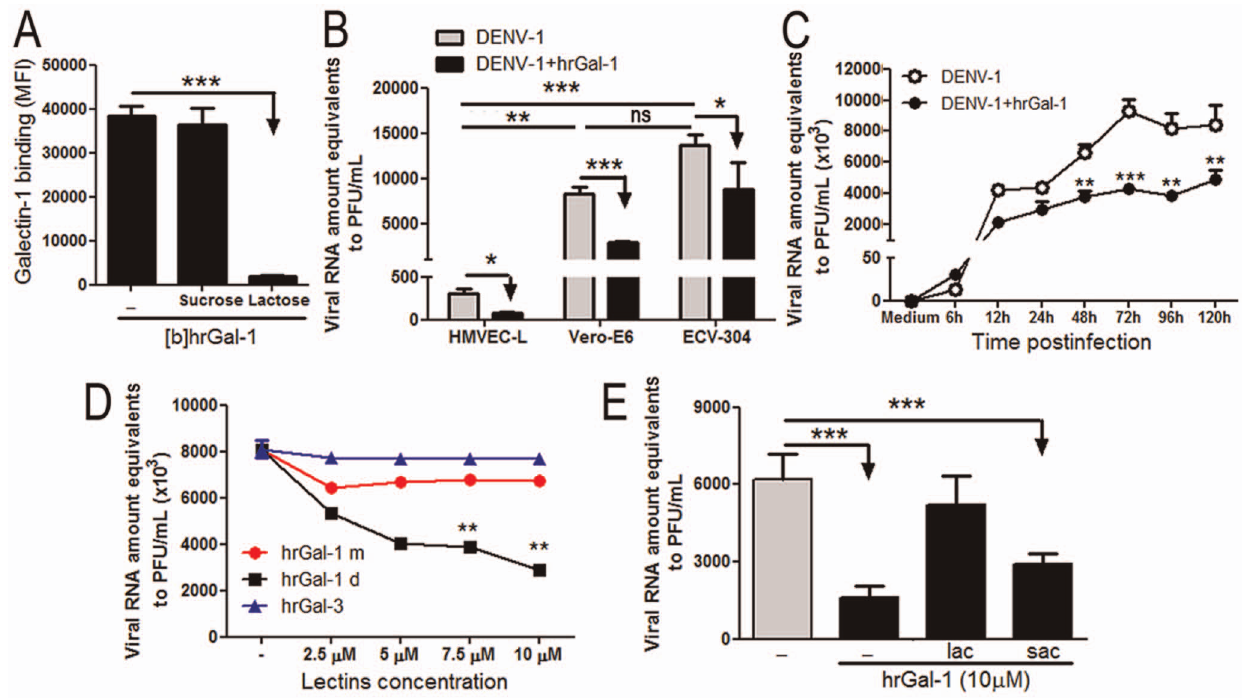
Figure 2. Treatment with human recombinant Gal-1 inhibits DENV-1 in vitro infection. (A) Biotinylated-hrGal-1 (20 m g/mL) was incubated with ECV-304 cells in presence or absence of 40 mM lactose or sucrose for 1 hour at 4 u C. The binding of biotinylated-hrGal-1 to ECV-304 cells surfaces was detected by staining with streptavidin-FITC and measured by flow cytometry. The analysis was performed using a Diva software (Becton Dickson) and results are expressed as mean mean fluorescence intensity (MFI) 6 SD. Tests were performed in triplicates. (B) HMVEC-L, Vero-E6 and ECV-304 cells were incubated with 10 m M hrGal-1 or only medium for 1 hour at 37 u C. Following, cells were inoculated with DENV-1 at a MOI of 0.5 and cultivated for 72 hours. At 72 hours postinfection the supernatants were collected and the viral RNA amounts were quantified by Real-Time PCR. Results are shown as Viral RNA amounts equivalent to PFU/ml 6 SD from 3 assays performed in triplicates. (C) ECV-304 cells were treated with hrGal-1 and infected with DENV-1 as described in (B) for 120 hours. The supernatants were collected at the indicated times postinfection and the viral loads were quantified by Real-Time PCR as described in (B). (N=3) (D) ECV-304 cells were incubated with increased concentrations of monomeric-Gal-1 (hrGal-1 m), dimeric-Gal-1 (hrGal-1 d) or galectin-3 (hrGal-3) for 1 hour at 37 u C before inoculation with DENV-1 (MOI 0.5). Cells were cultivated for 72 hours at 37 u C and viral load was quantified as described in (A) (N=3). (E) ECV-304 cells were treated with hrGal-1 (10 m M) in the presence of 40 mM lactose (LAC) or 40 mM sucrose (SUC) and then infected with DENV-1 as described in (B), for 72 hours. The viral load was quantified as described in (B). Data are representative from three independent experiments. *p , 0.01; **p , 0.001; ***p , 0.0001.